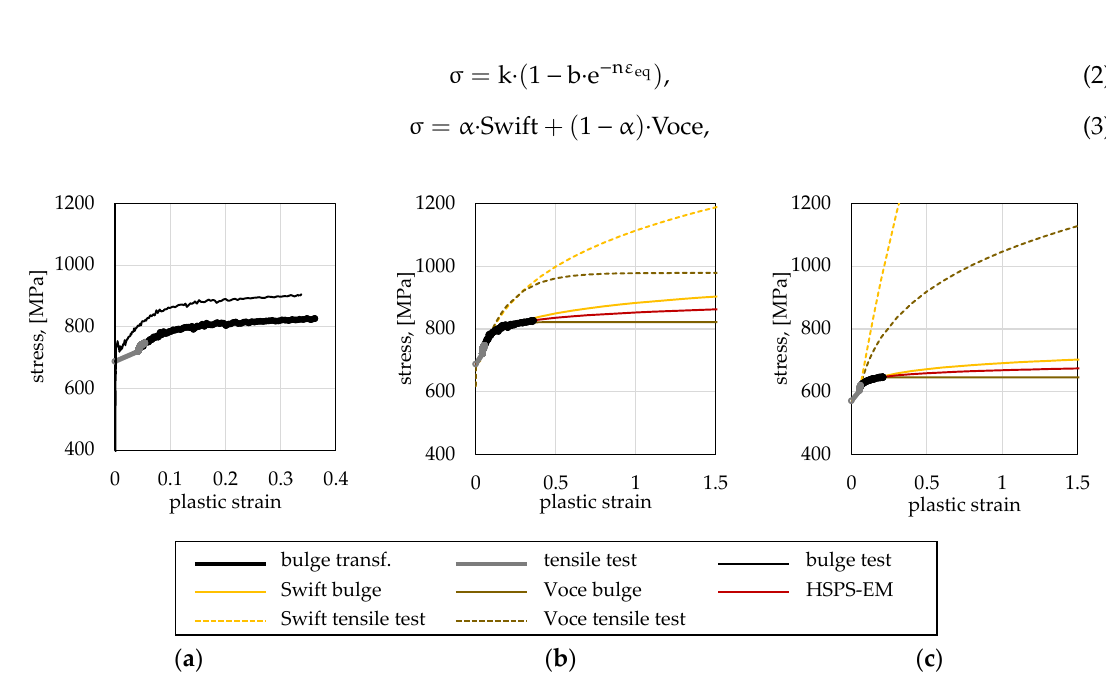
Figure 2. ( a ) Bulge test transformation; Comparison of the extrapolation methods for ( b ) TH700 and ( c ) TH620.